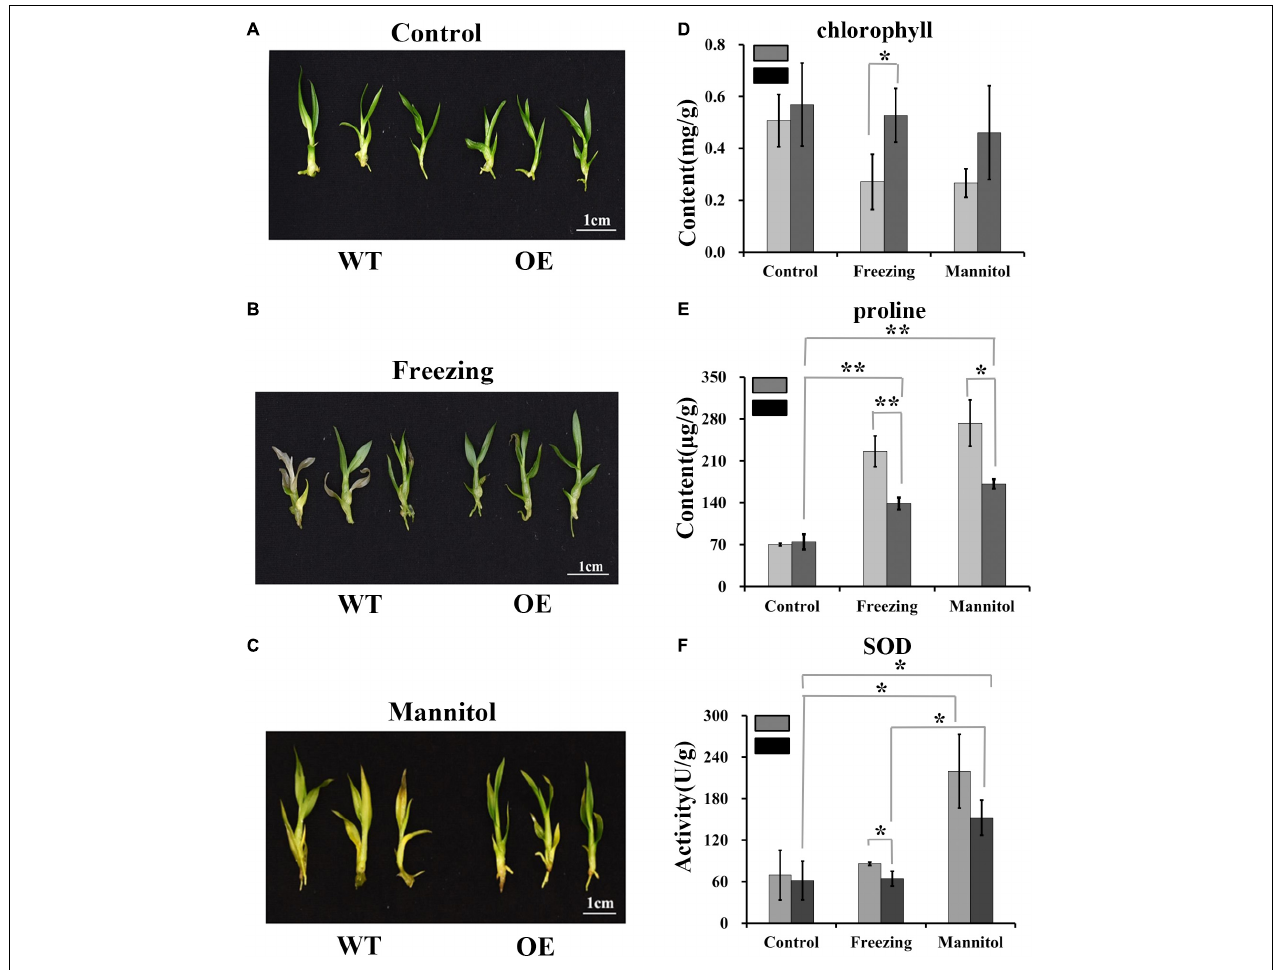
FIGURE 6 | Resistance of DoUGP overexpression plants to freezing and osmotic stress treatments. (A) Wild-type (WT) and DoUGP overexpression (OE) seedlings cultured without stress. (B) Wild-type (WT) and DoUGP overexpression seedlings treated at -20 ◦ C for 1 h and cultured for another 10 days. (C) Wild-type (WT) and DoUGP overexpression seedlings treated with 500 mM mannitol for 20 days. (D) Chlorophyll contents of wild-type (gray bar) and DoUGP overexpression (black bar) seedlings after freezing or osmotic stress treatments. (E) Proline contents of wild-type and DoUGP overexpression seedlings after freezing or osmotic stress treatments. (F) SOD activities after freezing or osmotic stress treatments. Chlorophyll, proline, and SOD contents were determined by using mixed materials from three independent transgenic seedlings. Results are presented as mean ± standard error calculated from three biological replicates. Asterisks indicate the statistically significant differences (Student’s t -test, p < 0.05).